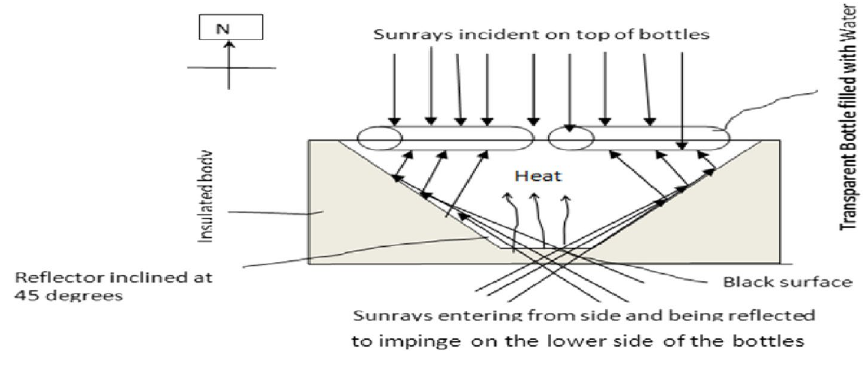
Fig. 2 A 3-D view of the improved SODIS design show- ing parts and basic dimensions (dimensions in mm, not to